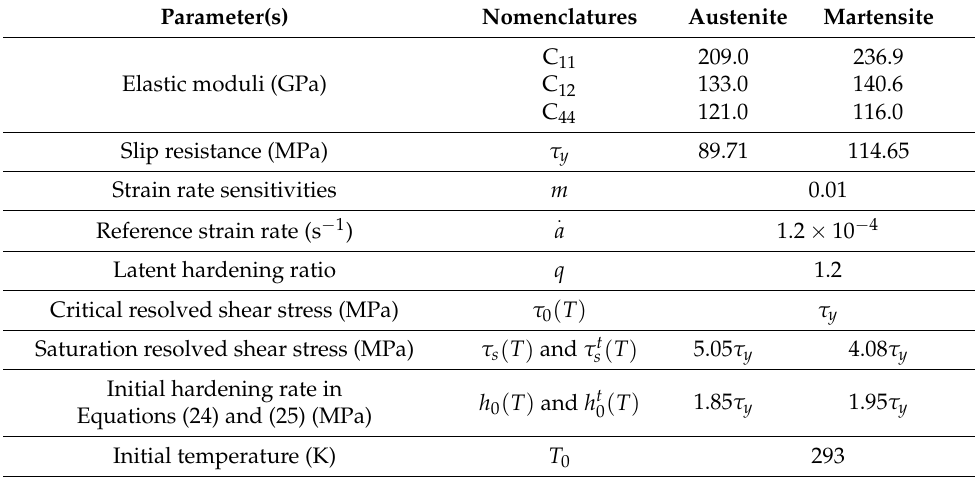
Table 1. Material constants and parameters of the